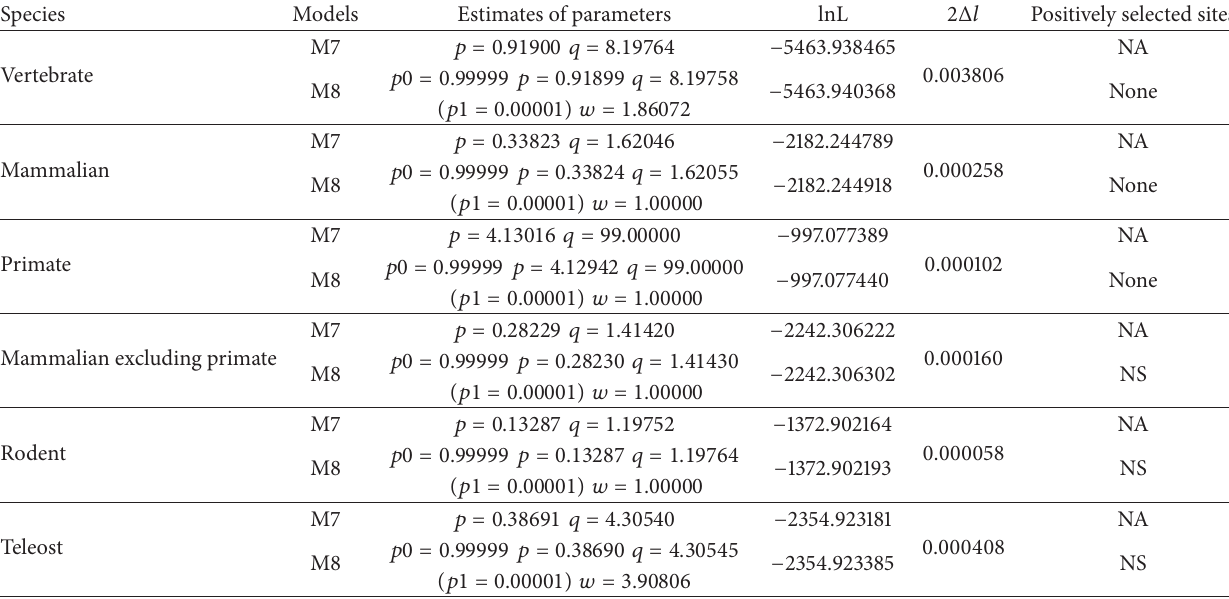
Table 1: Site-specific tests for positive selectionof